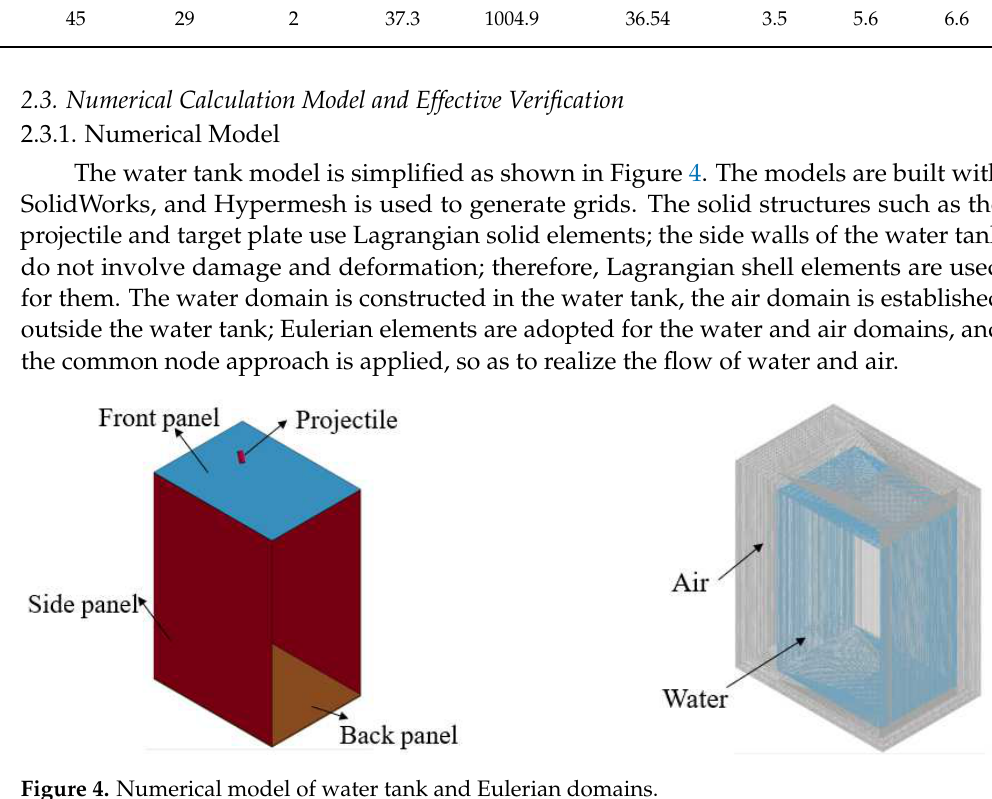
Table 2. Material parameters of Q235 steel.